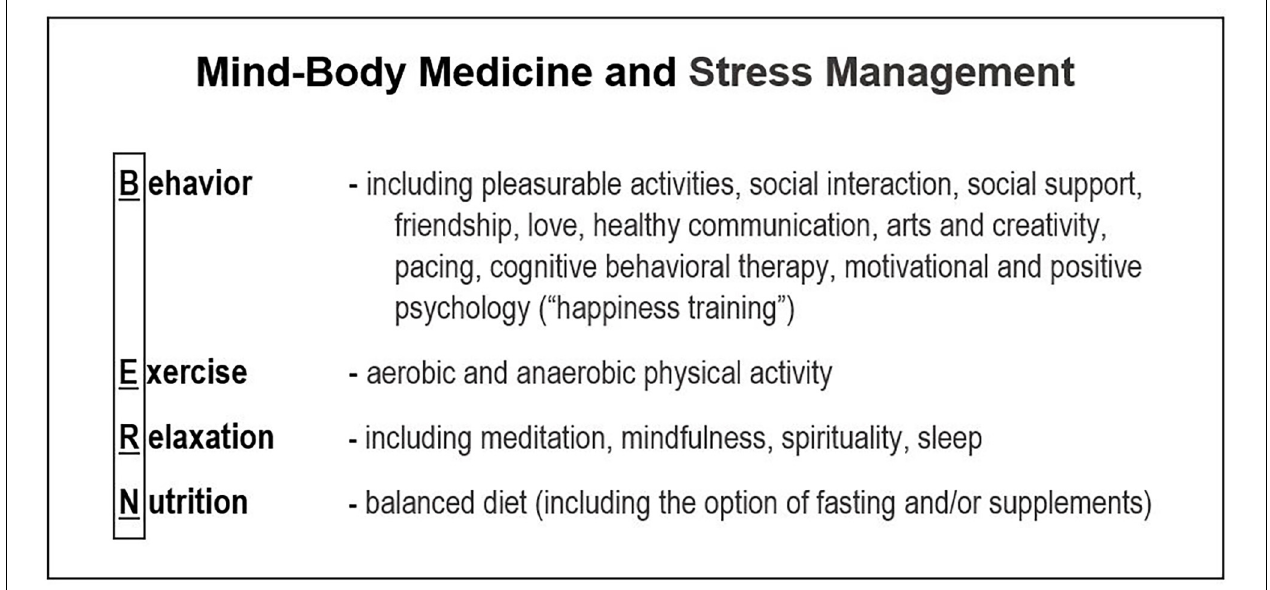
FIGURE 1 | The BERN framework of mind-body medicine (MBM). The four principles of integrative multimodal MBM and stress management programs include Behavior, Exercise, Relaxation, and